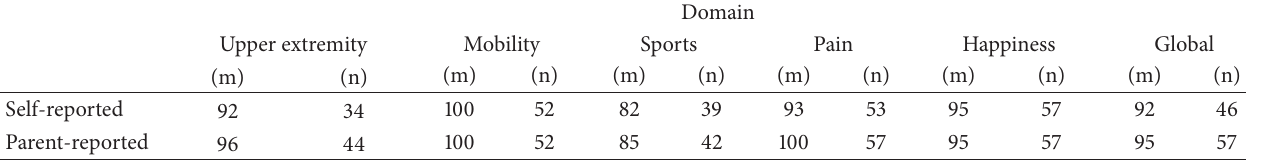
Table 1: PODCI domain scores.